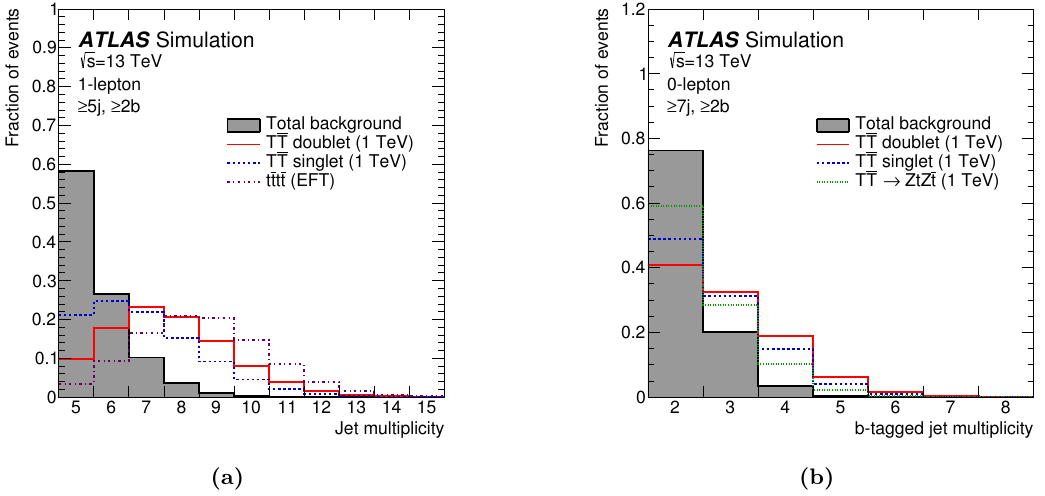
Figure 2. Comparison of the distribution of (a) the jet multiplicity, and (b) the b -tagged jet mul- tiplicity, between the total background (shaded histogram) and several signal scenarios considered in this search. The selection used in (a) corresponds to events in the 1-lepton channel satisfying the preselection requirements, whereas the selection used in (b) corresponds to events in the 0-lepton channel satisfying the preselection requirements and 7 jets. The signals shown correspond (cid:21)